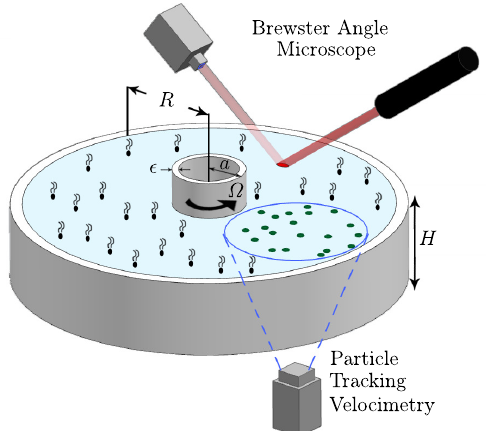
Figure 5. Schematic of the knife-edge geometry and the experimental set-up. (Reproduced with permission from [36], published by American Physical Society